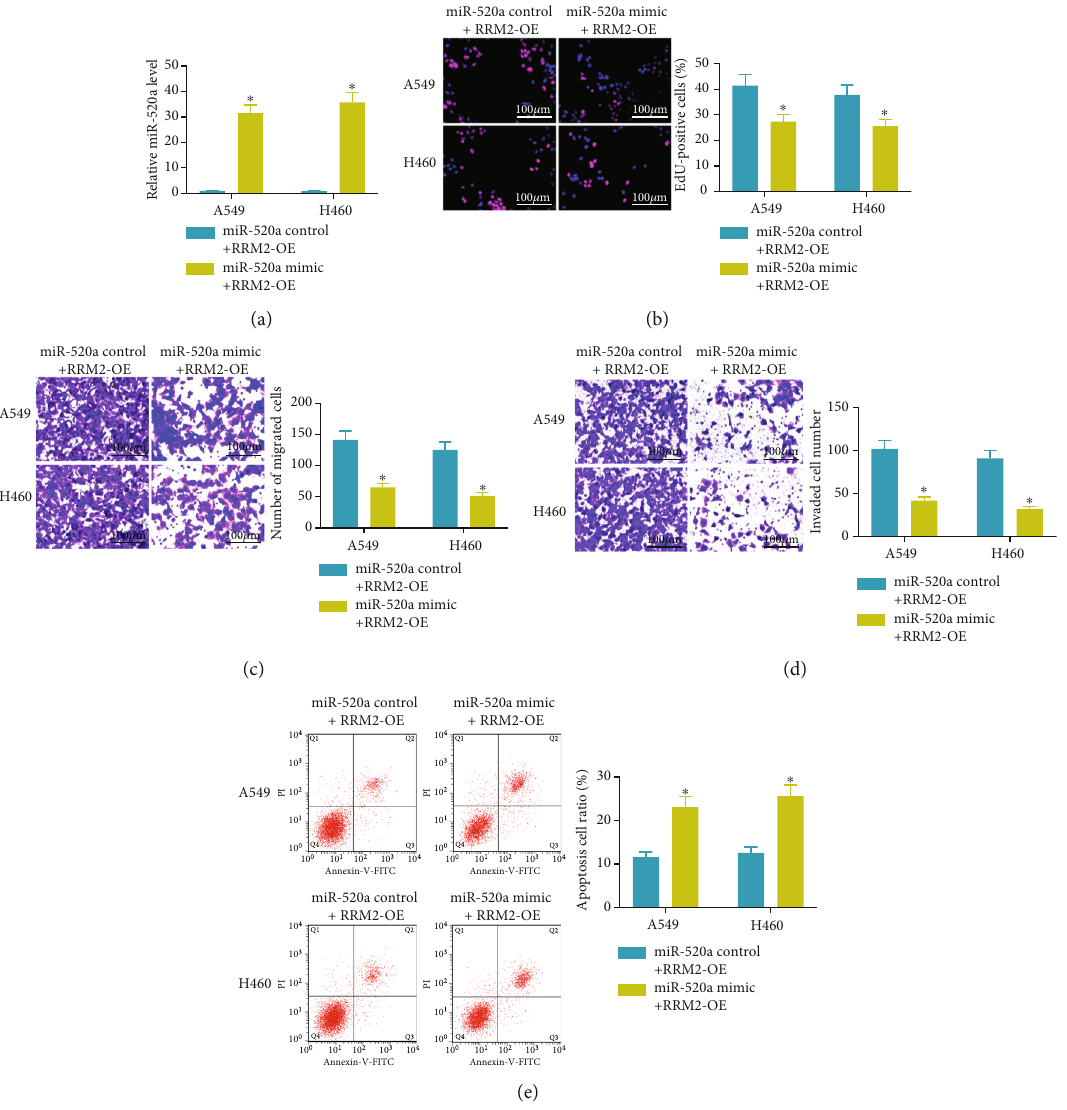
Figure 4: miR-520a inhibits the oncogenic e ff ects of RRM2 on NSCLC progression. (a) The miR-520a expression in A549 and H460 cells cotransfected with RRM2-OE and miR-520a mimic/control determined by RT-qPCR. (b) Viability of cells determined by the EdU labeling assay. (c, d) Number of migrating (c) and invading (d) cells determined by transwell assays. (e) The apoptosis rate of cells determined by fl ow cytometry; in all panels, ∗ p < 0 : 05 , two-way